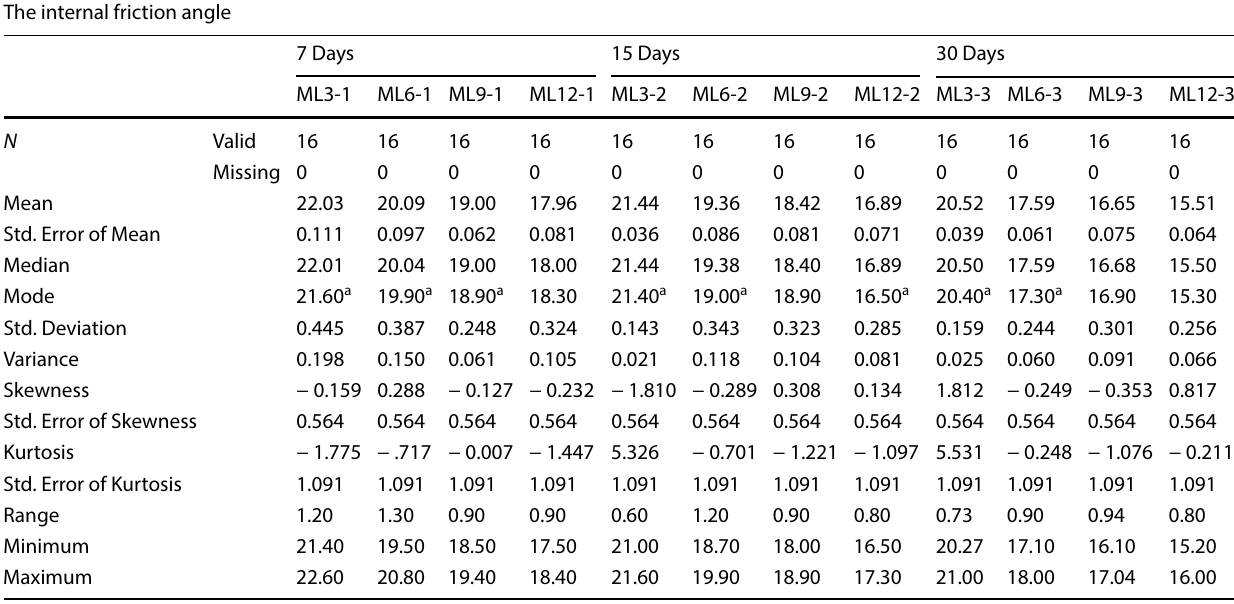
a Multiple modes exist. The smallest value is